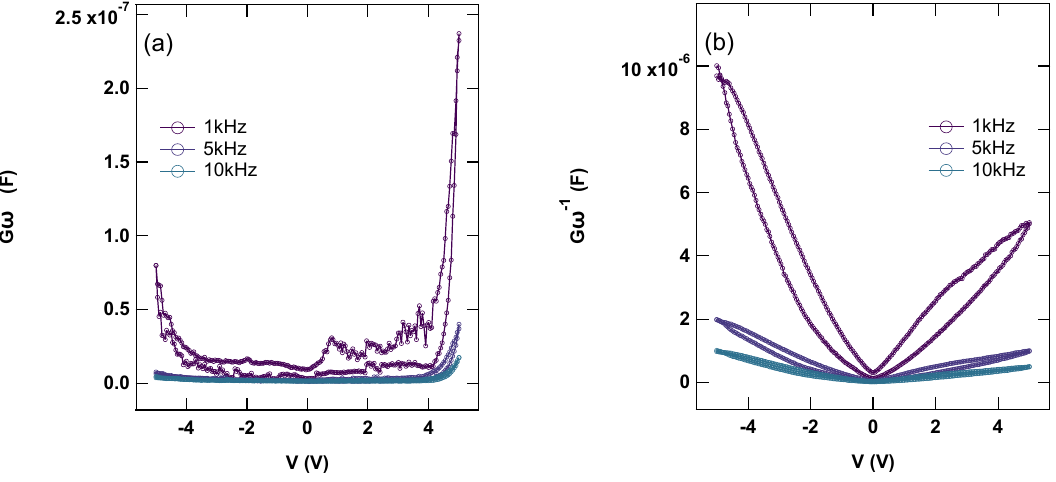
Figure 6. The Gω −1 vs. V sweep of the ITO/ReO 3 @ReS 2 /Al memcapacitor for ( a ) standard and ( b ) Figure 6. The G ω − 1 vs. V sweep of the ITO / ReO 3 @ReS 2 / Al memcapacitor for ( a ) standard and short-circuited device. Voltage sweep direction from −V to +V, I cc : 1 × 10 −2 A. ( b ) short-circuited device. Voltage sweep direction from − V to + V, I cc : 1 × 10 − 2